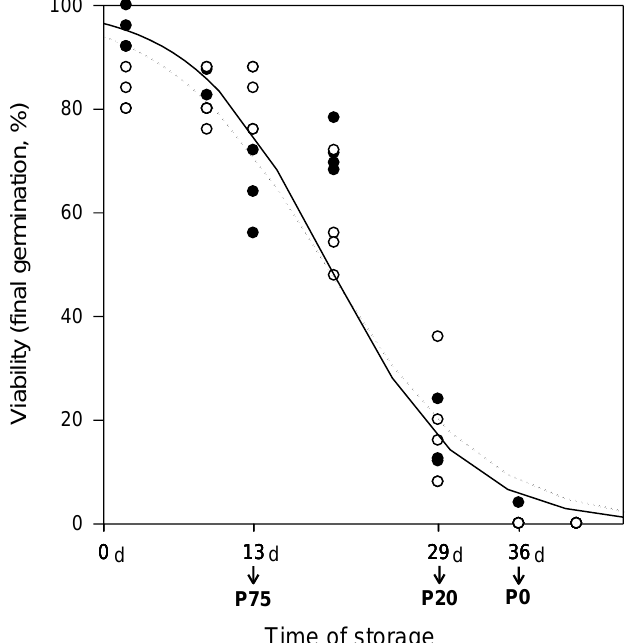
Figure 1. Viability loss of Secale cereale seeds during storage at 35 ◦ C, 15% water content (wc) and two di ff erent storage atmospheres: air (solid curve, • ) or vacuum (dotted curve, ). Each data point represents a germination assay in which the percentage of normal seedlings was measured for a particular storage condition and replicate (25 seeds). Data were fitted to a logistic regression model and values for 75, 50, and 20% seed germination (P75, P50, and P20) were calculated (Table 1).